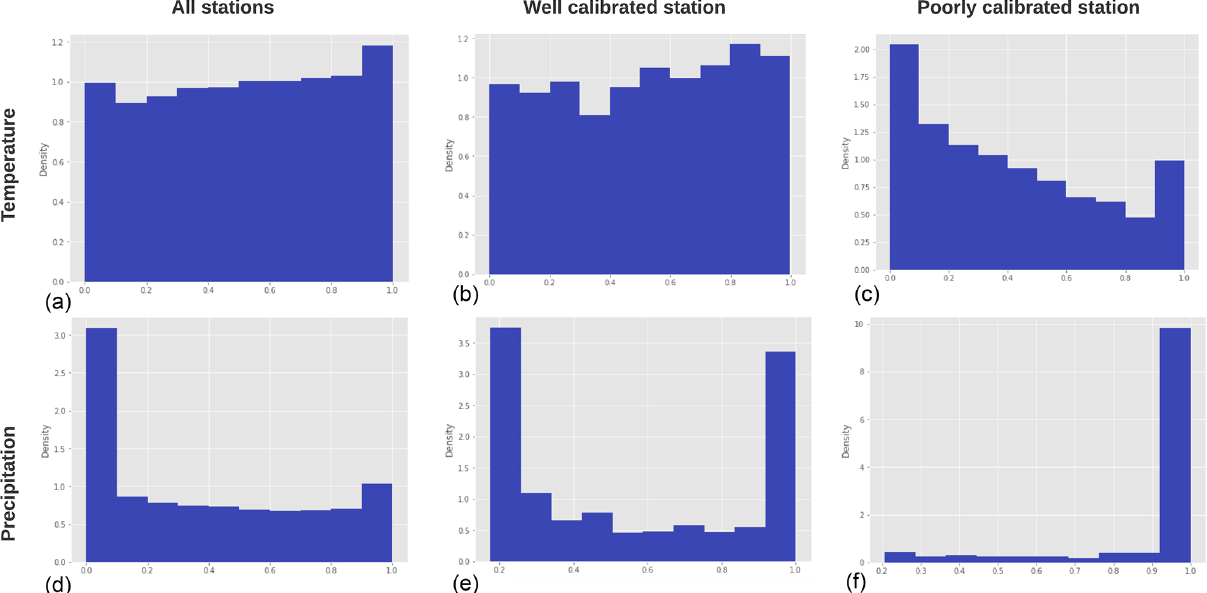
Figure 10. Histograms showing probability integral transforms for model predictions compared to a uniform distribution to assess calibration for temperature (a–c) and precipitation (d–f) . For temperature PIT plots are shown for all values (a) , a station where the model is well calibrated (Bragança, Portugal; b ) and a station where the model is poorly calibrated (Gospi´c, Croatia; c ). Similarly for precipitation, PIT plots are shown for all values (d) , a station where the model is well calibrated (Stornoway, UK; e ) and a station where the model is poorly calibrated (Sodankylä, Finland; f ).